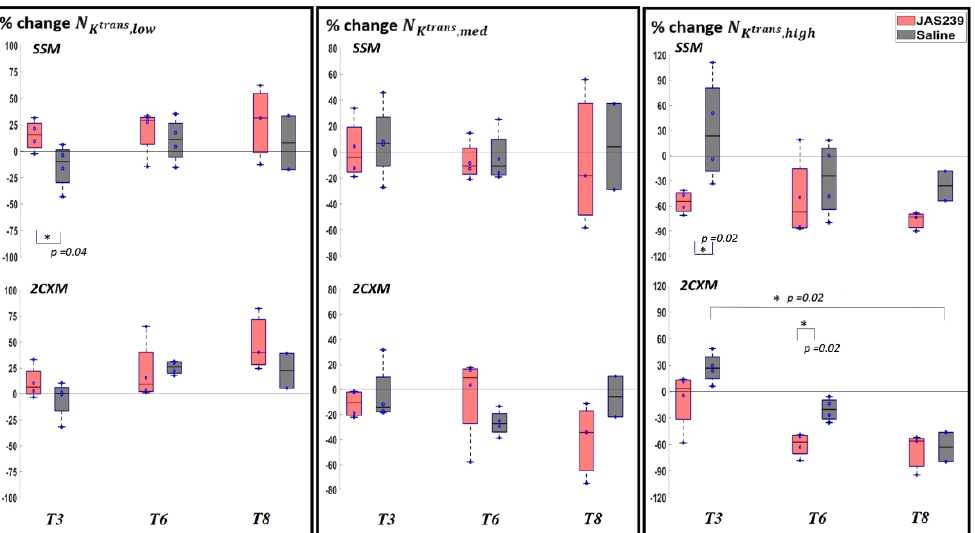
Figure 4. Box plot for percentage change (with respect to baseline) in 𝑁 𝐾 𝑡𝑟𝑎𝑛𝑠 ,𝑦 (where 𝑦 = low, med and high) in F98 rat GBM with JAS239 (red) and saline (grey) treatment at different time points using the SSM (top) and 2CXM (bottom) models, respectively. The asterisk indicates significant difference. No significant change or trend was noticed for the GL261 mice treated with JAS239 (Figure 5 and Figure S4).